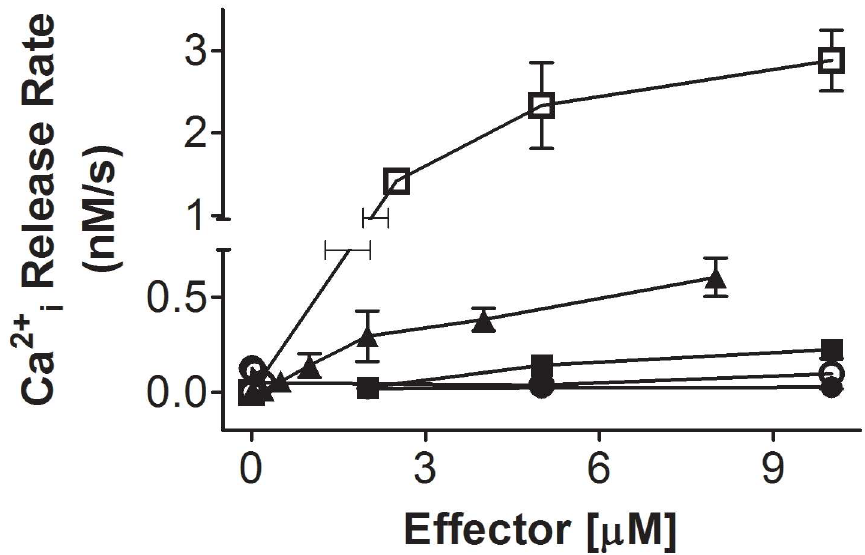
Fig 1. Dose-response curves. Dose-response curves for grifolic acid ( □ ; GPR120 agonist), Arachidonic acid ( ▲ ), GPR120 agonistIII ( ■ ), GPR40 agonist(PPMAPP; ○ ) and GPR40 agonistII ( ● )-induced release of intracellular Ca 2+ in round spermatids vs. their concentrations. Cells were loadedwith fura-2 and incubatedin KH-lactate-EGTA media without addedCa 2+ at 33˚C. N = 3 for each agonistconcentration